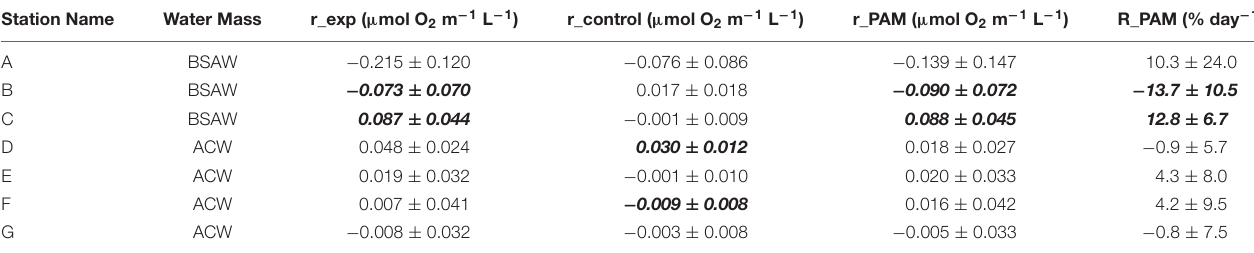
FIGURE 3 | Sinking particles collected in polyacrylamide gel traps at station A (A,B) and station D (C,D) . Sinking particles at station A are characteristic of Bering Shelf/Anadyr Water stations and consist exclusively of fluffy aggregates made of diatoms and viable diatom chains. Sinking particles at station D are characteristic of Alaska Coastal Water stations and consist of a more diverse set of particles, including fecal pellets, zooplankton swimmers, as well as still viable and senescent diatoms. TABLE 4 | Particle-associated microbial respiration rates and carbon specific rates for sinking